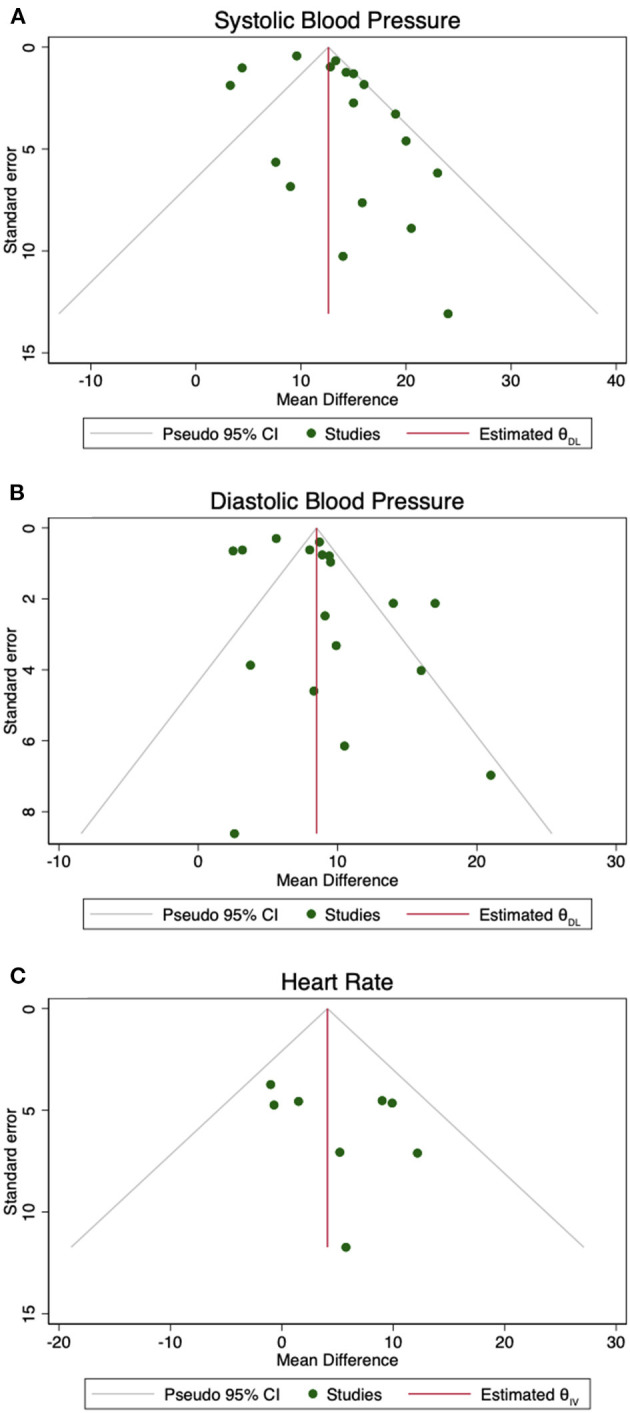
Funnel plots. These plots depict the standard error against the log mean difference in order to assess for publication bias. Symmetry in (A) SBP, (B) DBP, and (C) HR provides an assessment of publication bias, verified by the Egger's test.